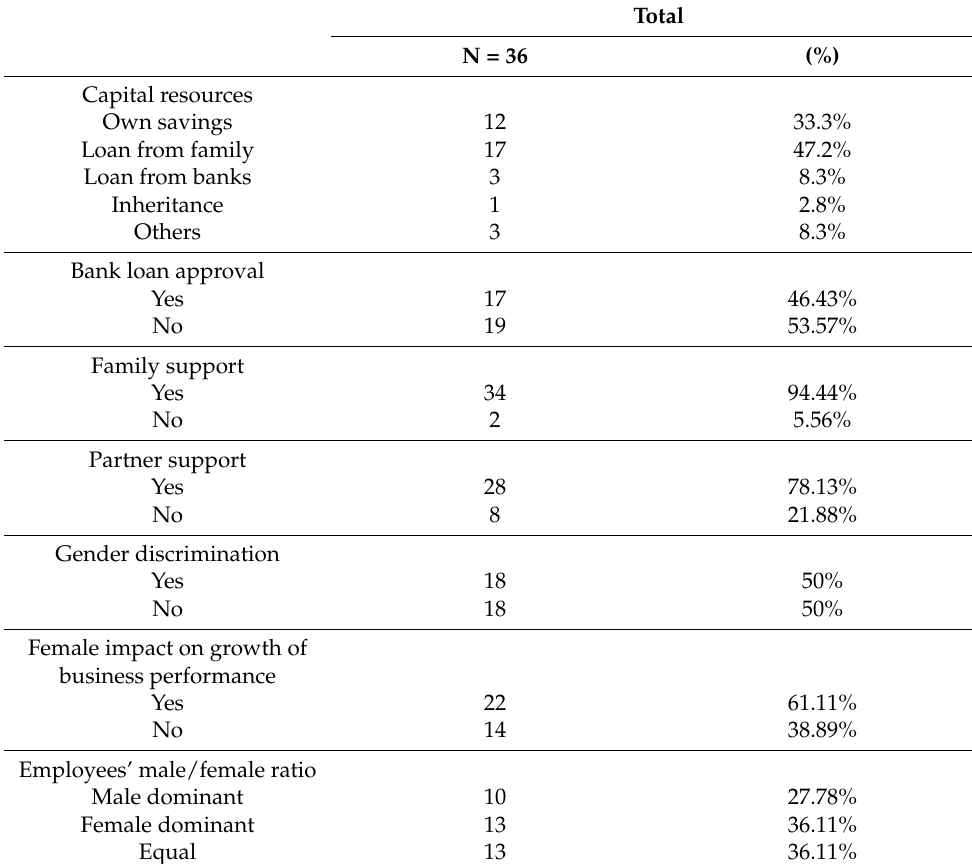
Table 3. Support vs.